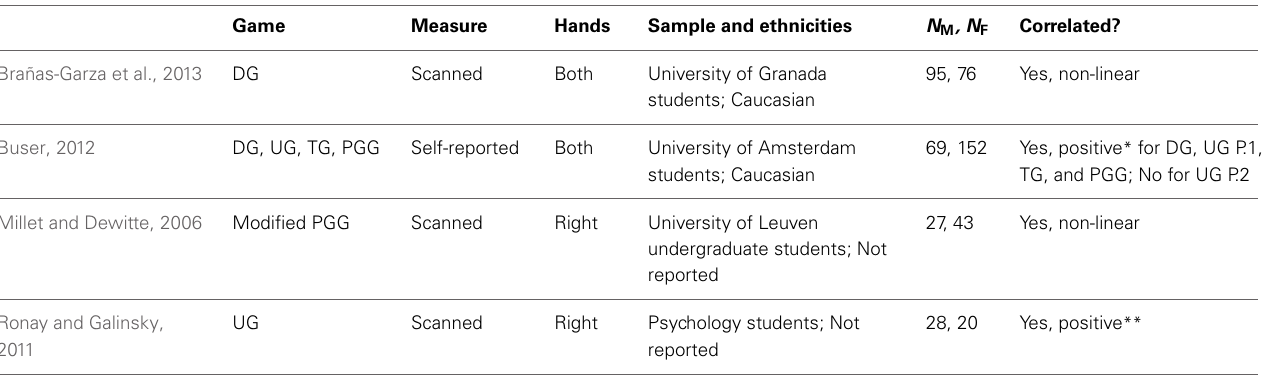
Table 1 | Summary of studies on digit ratio and pro-social behavior in experimental games with real monetary